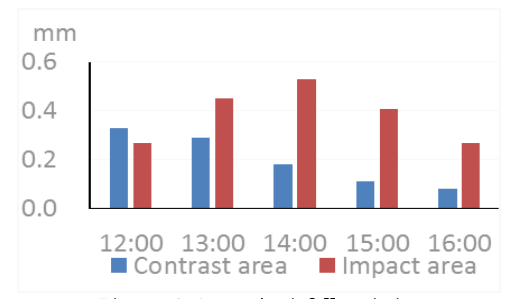
Figure 18. Ground rainfall